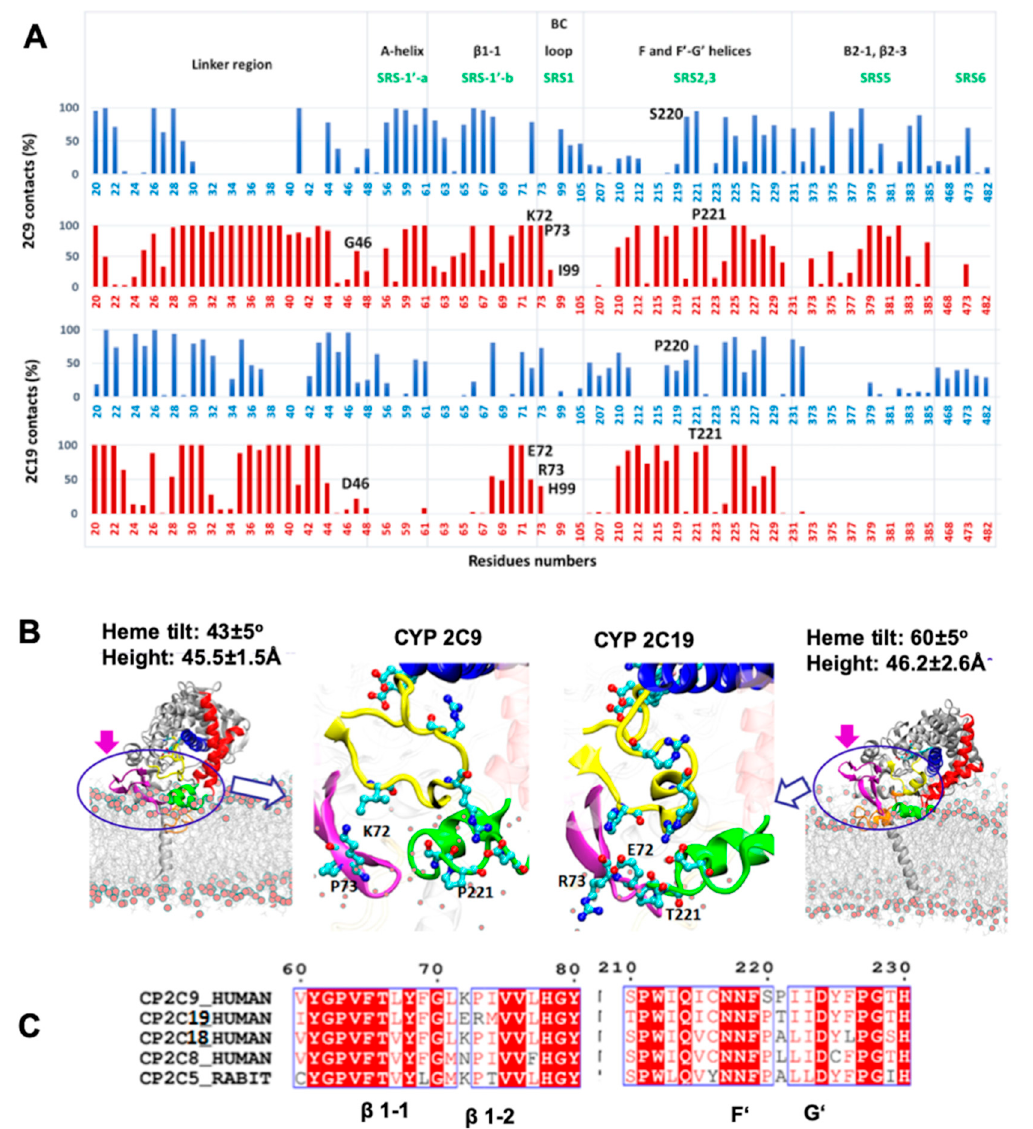
Figure 5. Differences in the arrangements of the CYP 2C9 and CYP 2C19 residues at the membrane interface. ( A ) Residues in contact with the lipid head group (blue) and tail region (red) during the AA MD simulations of CYP 2C9 (above) and CYP 2C19 (below). The percentage of snapshots in which a contact was present is shown on the y-axis, and the residues interacting with the membrane are given on the x-axis. The secondary structures and substrate recognition sites are shown on the top. The residues differing in the interacting regions between CYP 2C9 and CYP 2C19 are labeled. ( B ) For CYP 2C9 (left) and CYP 2C19 (right), the last frames from AA MD simulations of the apo form (SIM1) are shown for the full system and for the membrane interface region. The protein is shown in cartoon representation with selected side chains in ball-and-stick representation colored by atom type with cyan carbons. The linker is shown in orange, β -sheets 1 and 2 in magenta, the B–C loop in yellow, the F and G helices in red, the F’ and G’ helices in green, the central I-helix in blue, and the heme and key residues in cyan licorice representation. The POPC bilayer is shown in grey line representation with phosphate atoms as red spheres. The magenta arrows indicate di ff erences in β -sheet 2 (residues 370–380). ( C ) Part of a sequence alignment of human CYP2C subfamily members (2C9, 2C19, 2C18, 2C8) and rabbit CYP 2C5. The conserved residues are shown in red for similar residues or with a red background and in white for identical residues. The residues outside the blue boxes di ff ered amongst the aligned CYPs.